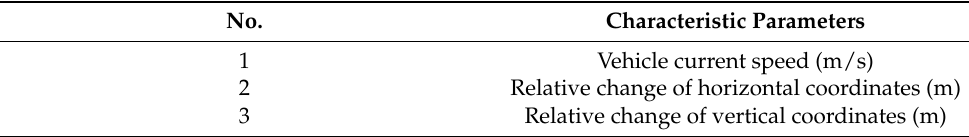
Table 1. Table of horizontal characteristic parameters.